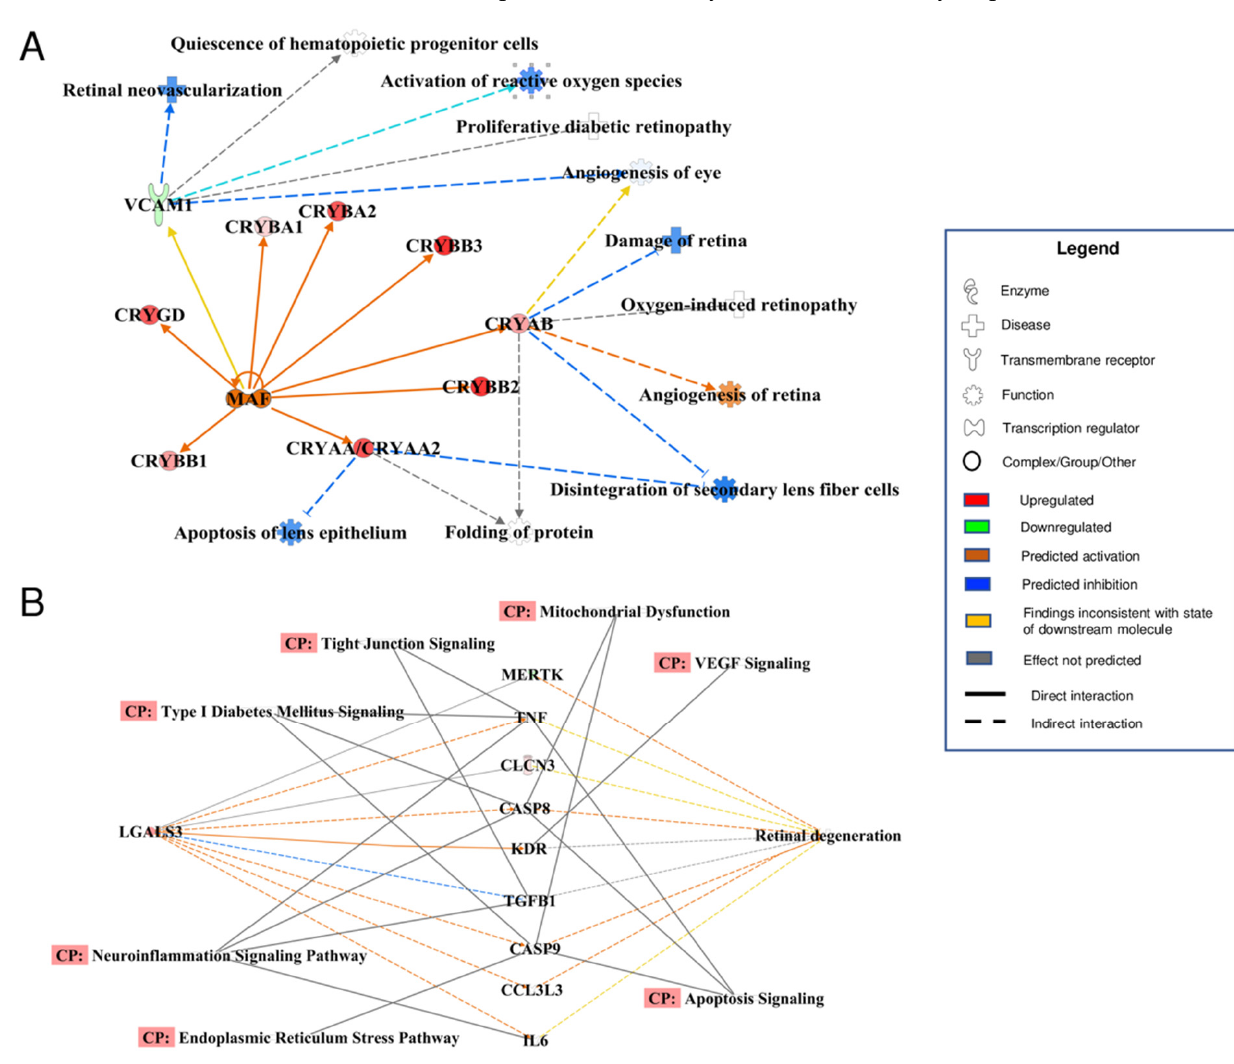
Figure 8. Interaction maps of MAM proteins and associated eye pathologies and canonical DR-related signaling pathways. MAM proteins with notable associations with specific signaling pathways and eye pathology underlying DR were selected from the 179 altered MAM proteins in the Type 1 diabetic condition. ( A ) Eight crystallin proteins and VCAM1 were notably identified as having associations with MAF. VCAM1 and several specific crystallin proteins (CRYAB, CRYAA/CRYAA2) were found to have numerous ties to the onset of various eye pathologies. ( B ) LGALS3 is a key MAM protein that is associated with processes of retinal degeneration via multiple specific protein-protein interactions. The functional networks were generated through IPA. Figure legend displays molecules and function symbol types and colors. Lighter shades of red, green, and blue represent decreased intensities of up-regulation, down-regulation, and inhibition, respectively. MAM: Mitochondria-associated ER membrane, IPA: Ingenuity pathway analysis, VCAM-1: Vascular cell adhesion molecule 1, MAF: MAF bZIP transcription factor, CRYAA: Crystallin alpha A, CRYAA: Crystallin alpha B, CRYAA2: Crystallin alpha A2, LGAL3: Galectin 3. Table 2. Differentially expressed MAM proteins in retinal and brain tissues in animal models of Type 1 or Type 2 diabetes.